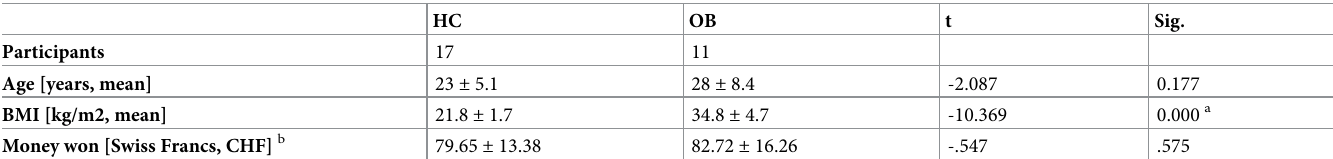
Table 1. Description of the study